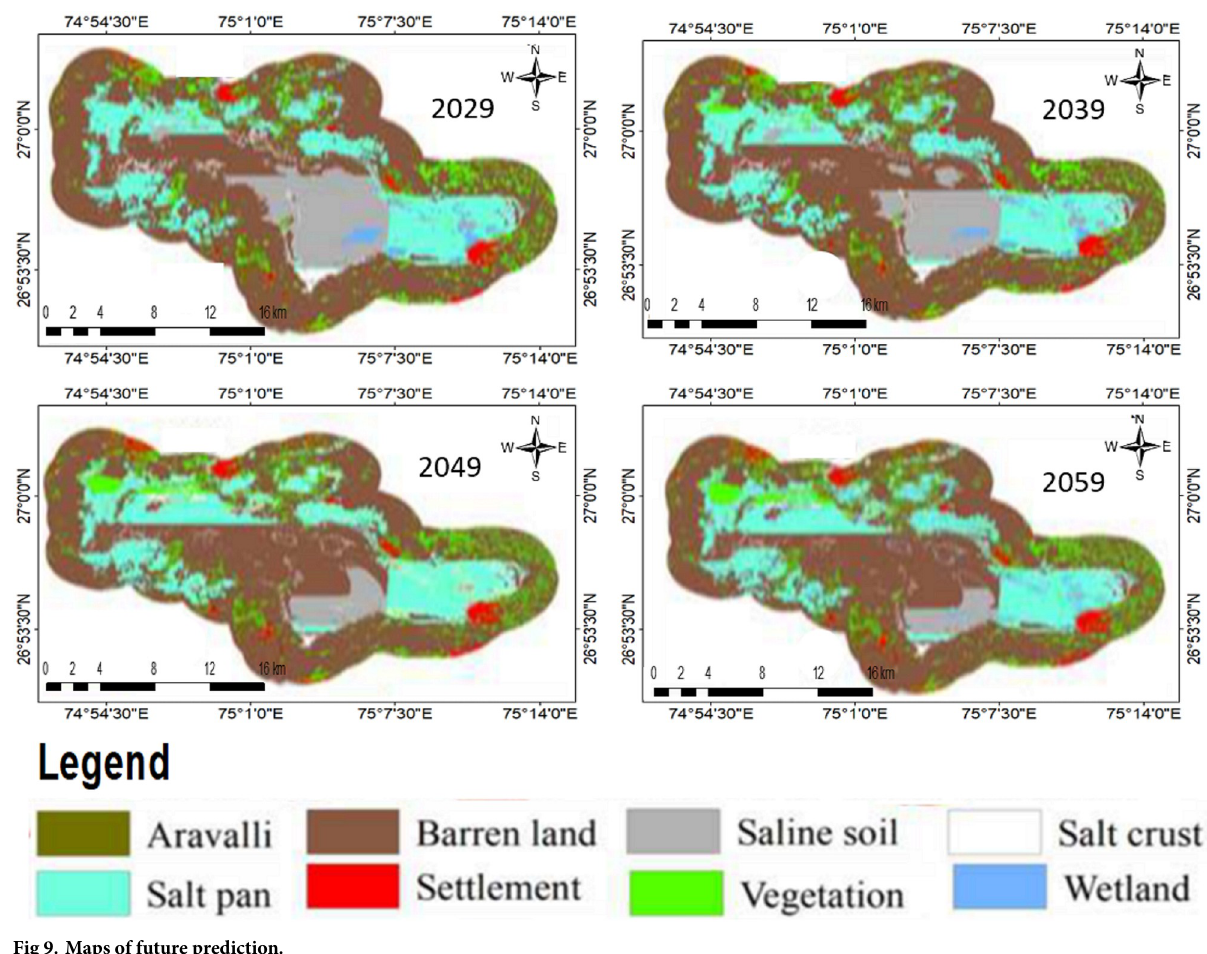
Fig 9. Maps of future prediction. contributions to saline soil are by wetland and salt pan by 0.1% and 0.5% and negatively by 5% by barren land. Positive contribution in the salt crust is by 0.1% and negatively by vegetation and barren land by 0.2% and 0.24% respectively. Positive contributions to the salt pan by bar- ren land are by 2.79% and negatively by wetland, vegetation, and saline soil. The settlement would experience positively by vegetation, salt pan, barren land, and Aravali hills by 0.18, 0.02, 0.34, and 0.1% respectively and negatively by saline soil by 0.01%. Vegetation will experience positively by salt pan by 0.8% and barren land by 0.7% and negatively by settlement by 0.21% and lastly wetland will experience positively by salt pan by 0.30%, barren land by 0.10% and negatively by saline soil by 0.25%. Spatial cubic trend changes of SSL are given in (Fig 11). Discussion Loss of saline character The topmost layer of SSL (0–1.15 m) appears greyish brown to dark grey from top to bottom due to organic residues with minerals of Kieserite providing brine rich in carbonate, sulphate, calcium, magnesium, 1.15–3.6 m appear dark grey with bloedite and brine rich in sodium, 3.6–6 m is rich in calcite, polyhalite, gypsum, dolomite and brine rich in same constituents